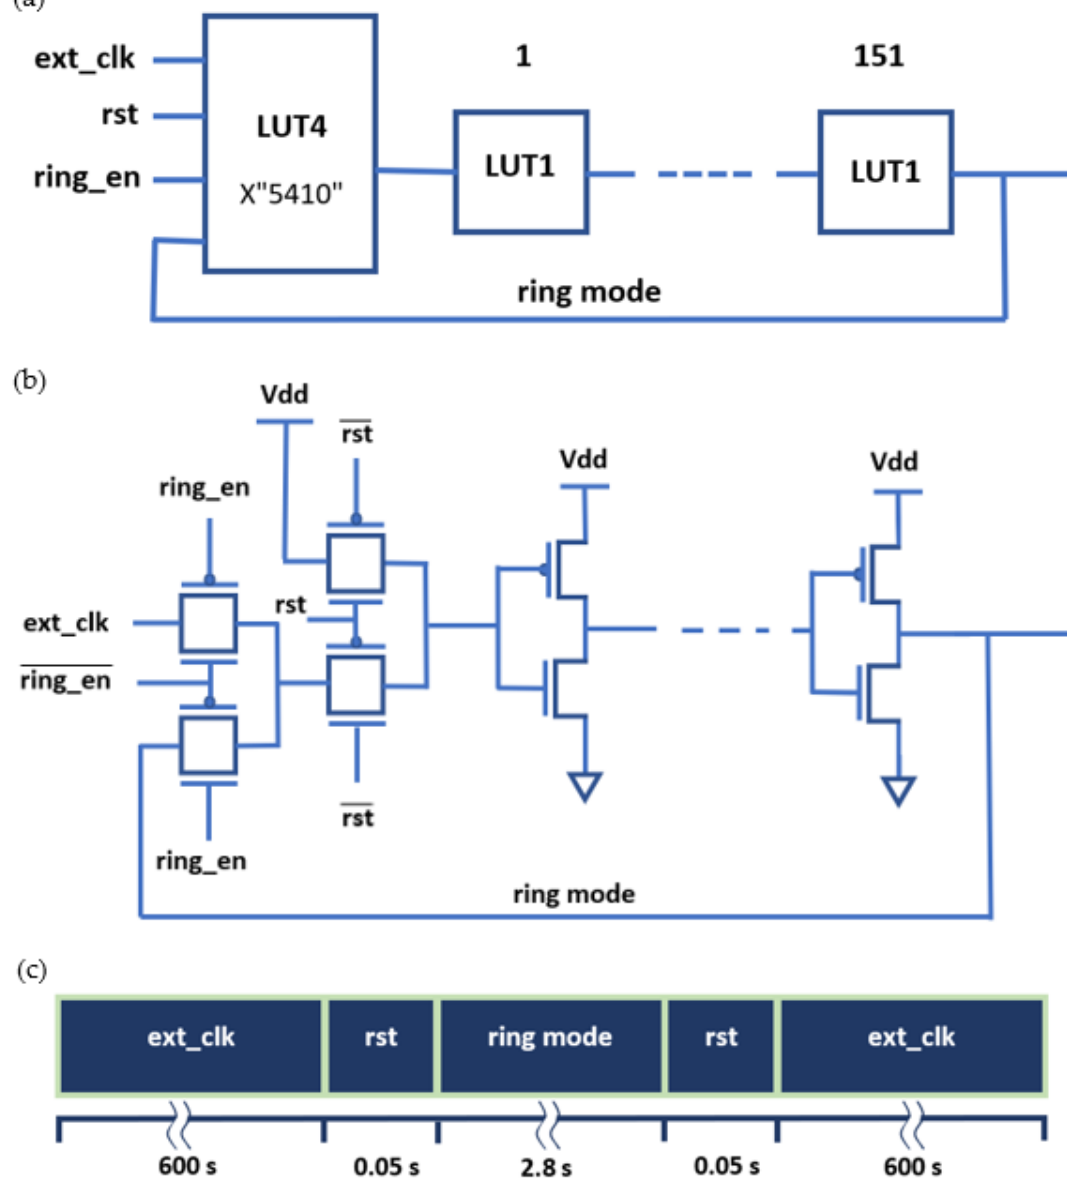
Figure 13. Diagram of the frequency locked loop (FLL) circuit: ( a ) Block diagram of lookup ta- bles (LUTs). ( b ) The wire layout showing the connections of the circuit. ( c ) Timeline of the FLL operation